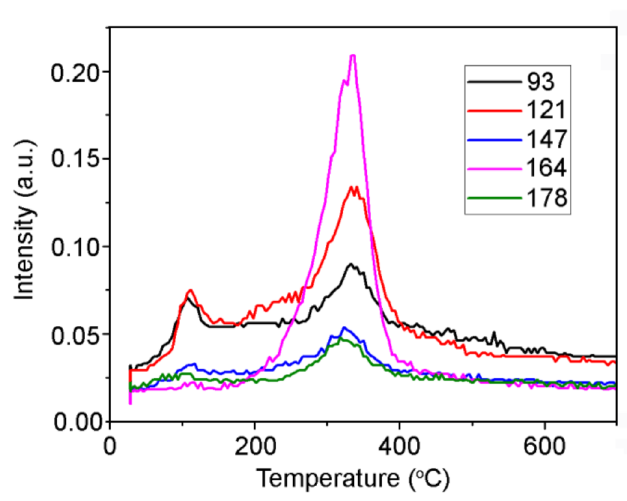
Figure 14. TPD-curves for the ion with m / z 93, 121, 147, 164, and 178, obtained by thermal decompo- sition of samples of FA/CeO 2 .